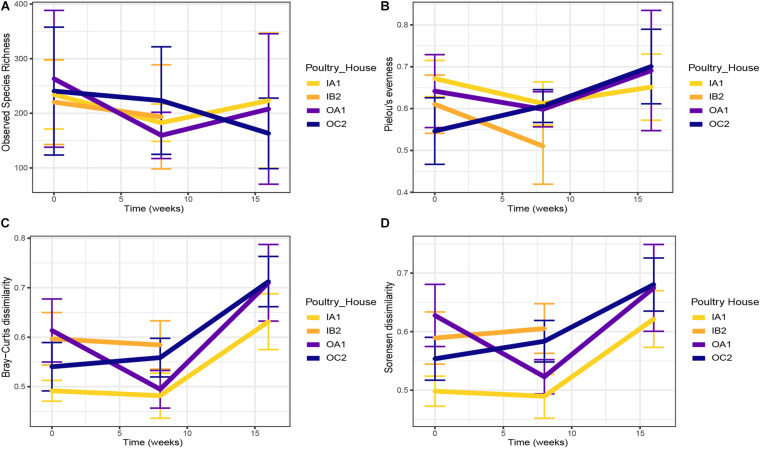
Temporal trends in observed species richness (A) and Pielou’s evenness (B) per poultry house at each sampling time. Pairwise Bray–Curtis (C) and Sørensen (D) dissimilarities between the cloacal microbiota of layers from poultry house at each sampling time. In C and D, greater values indicate higher dissimilarity. Means ± confidence interval are shown. Time is shown as weeks since first sampling.